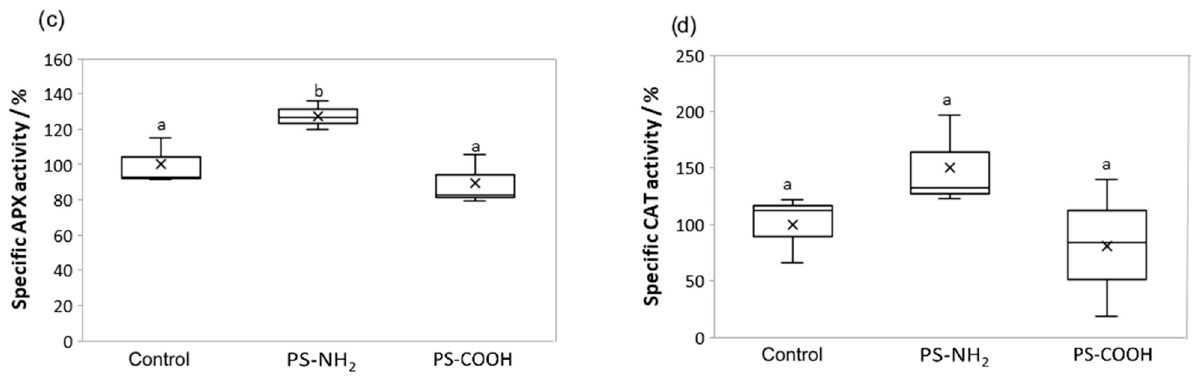
Figure 5. Antioxidant enzyme activities of Cylindrotheca closterium exposed to PS-NH 2 and PS- COOH nanoplastics. Boxplots showing the differences in specific activity of superoxide dismutase (SOD) ( a ), pyrogallol peroxidase (PPX) ( b ), ascorbate peroxidase (APX) ( c ), and catalase (CAT) ( d ) in C. closterium cultures in the exponential growth phase (day 7), when exposed to PS-NH 2 NPs (5 µg mL − 1 ) and PS-COOH NPs (200 µg mL − 1 ). Values are expressed as a percentage of control; a box with whiskers represents a median ± interquartile range (Q3–Q1). If boxes are marked with different letters, the treatments are significantly different at p ≤ 0.05 (general linear model, followed by the Newman - Keuls post hoc test).